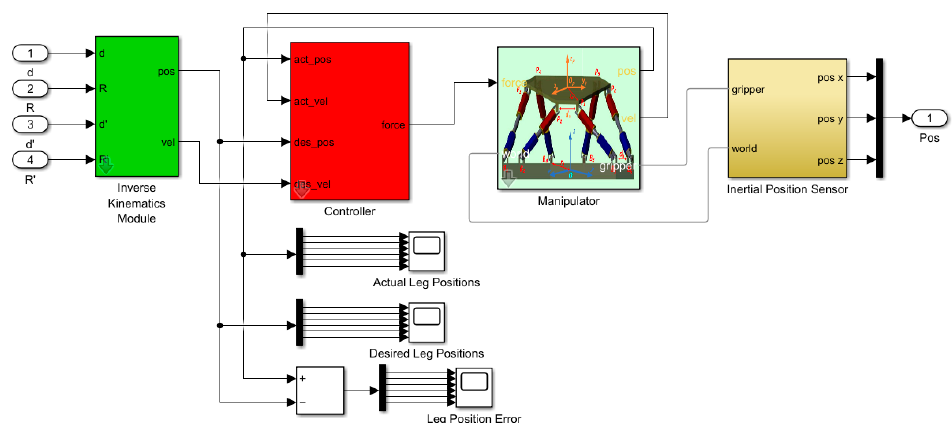
Figure 5. Simulink model of the PID controller and the inverse kinematics module.